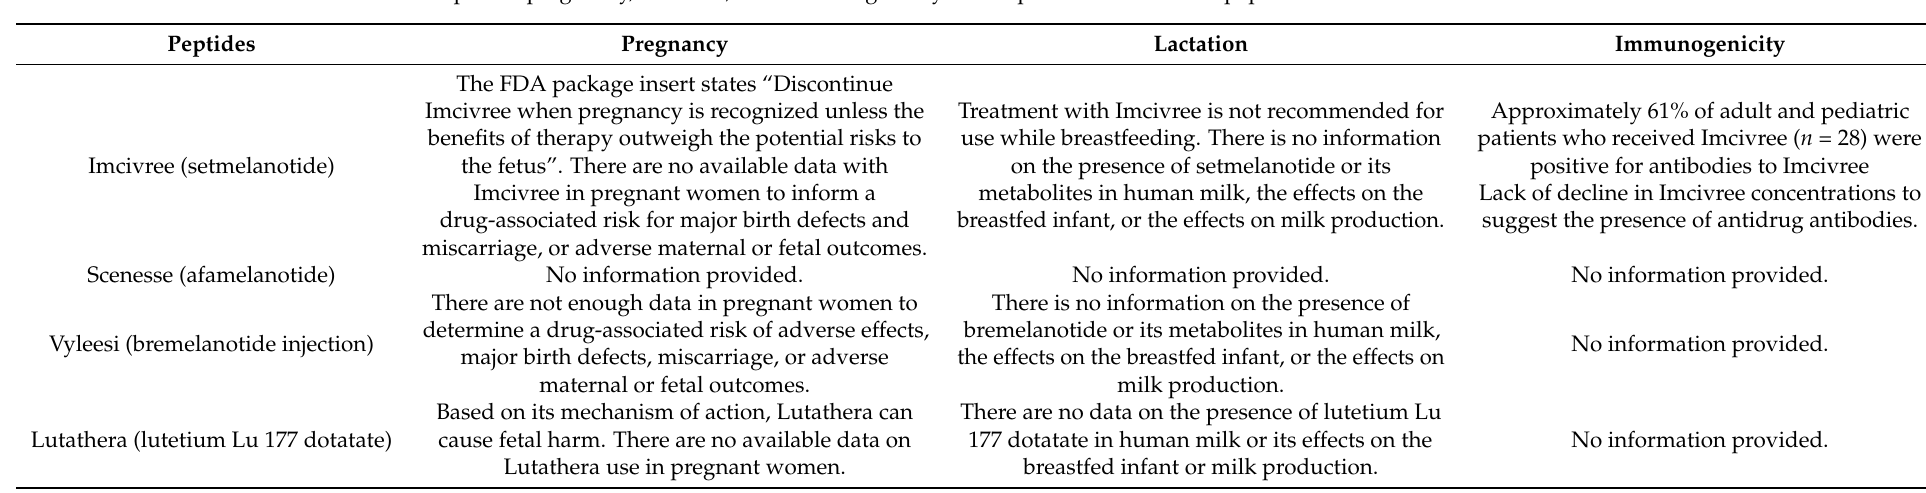
Table 4. Impact of pregnancy, lactation, and immunogenicity on the pharmacokinetics of